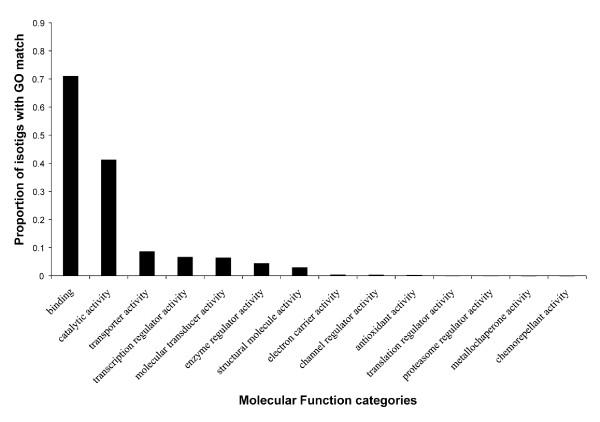
Gene Ontology Biological Process designations of isotigs. Representative isotigs were subjected to Gene Ontology (GO) analysis using Blast2GO. Categories are level 2 Biological Process designations. Proportion on the y-axis was calculated from the total number of representative isotigs that were annotated with GO terms (11,140).